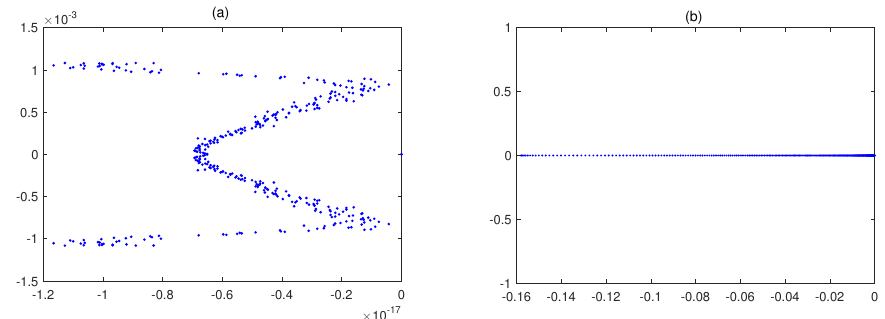
Figure 14. The eigenvalues of A ( a ) and B ( b ) for N = 500, n i = 111 and c = 1.26 in Example